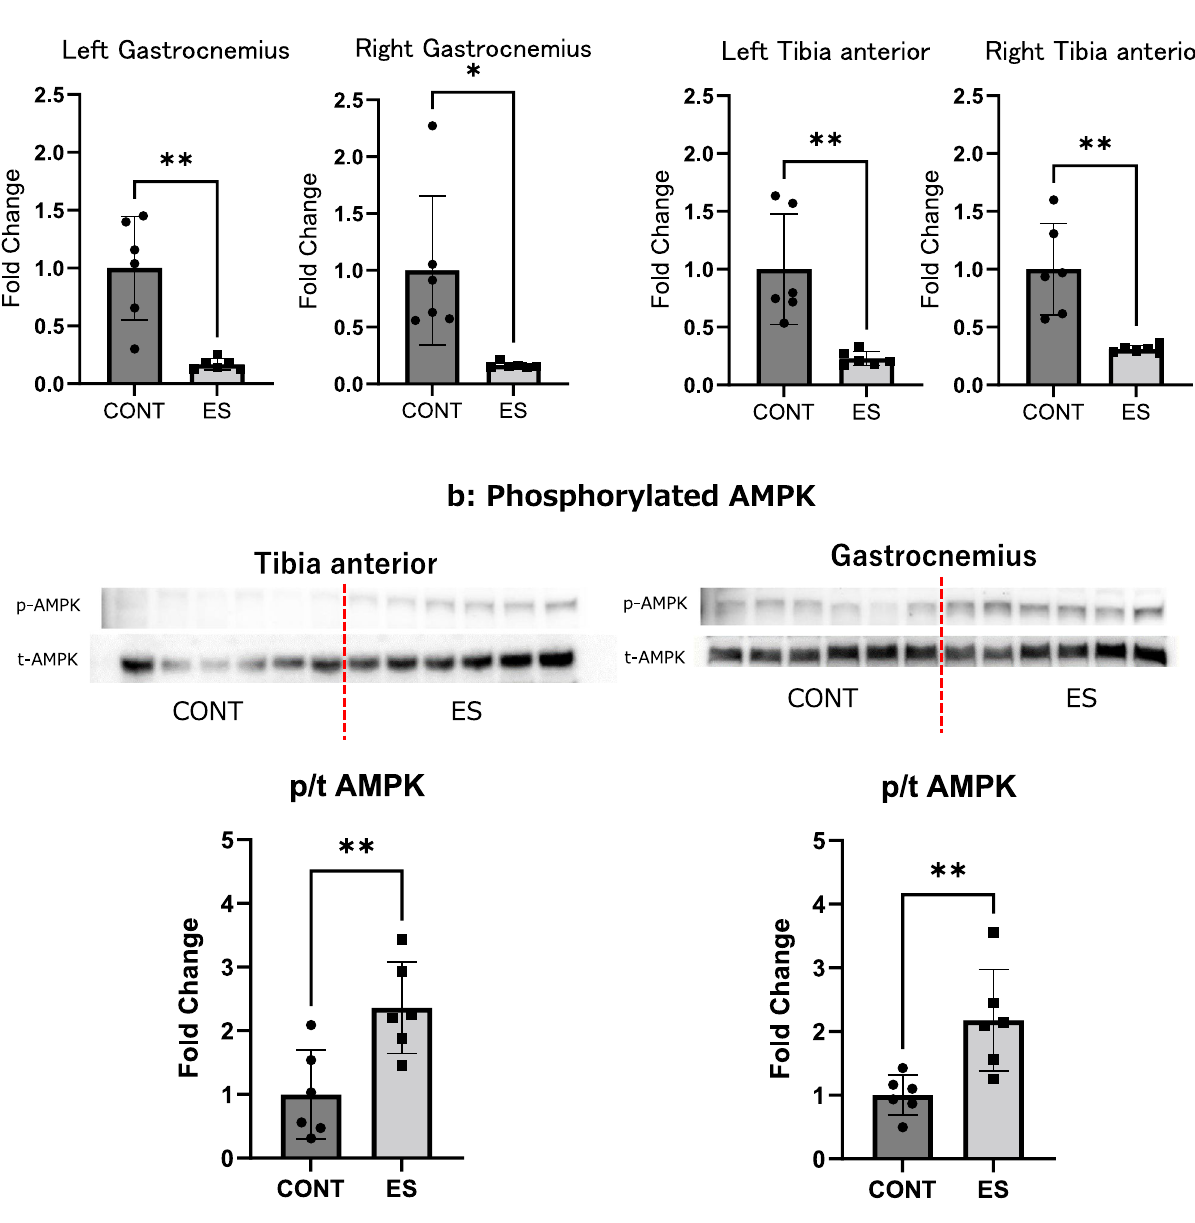
Figure 1. Glycogen content ( a ) and phosphorylated AMPK ( b ) of TA and GAS after belt electrode acute stimulation. ( a ) Glycogen content of GAS and TA ( b ) Phosphorylated AMPK of GAS and TA. Mean ± SD. An unpaired t test was used to evaluate changes in glycogen content and phosphorylated AMPK of lower limb muscles immediately after acute stimulation with the belt electrode. CONT unstimulated control group, ES group electrical stimulation by belt electrode; *p < 0.05, **p <